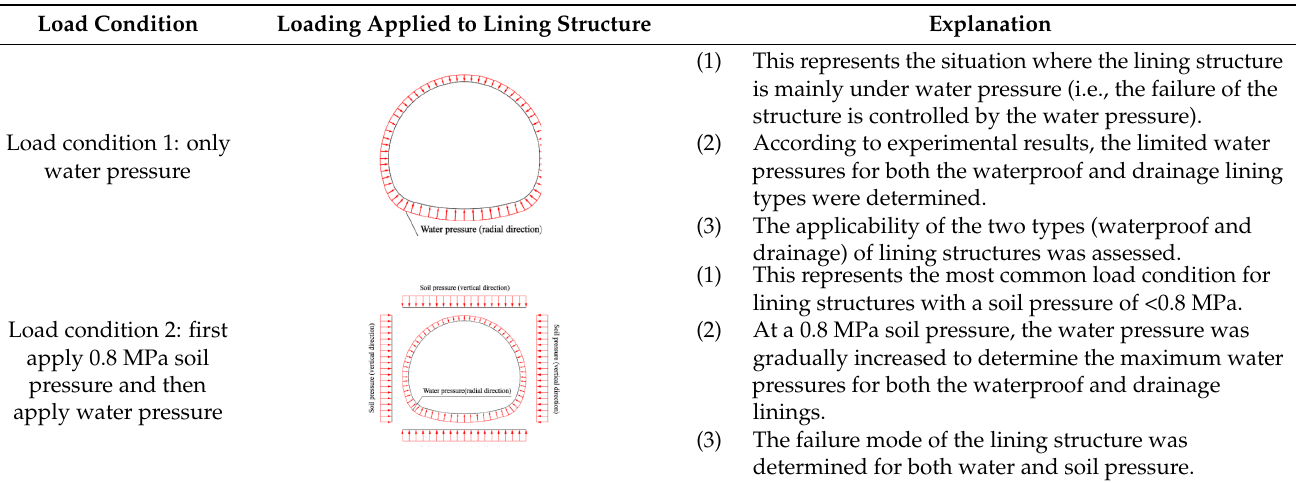
Table 5. Experimental category and load